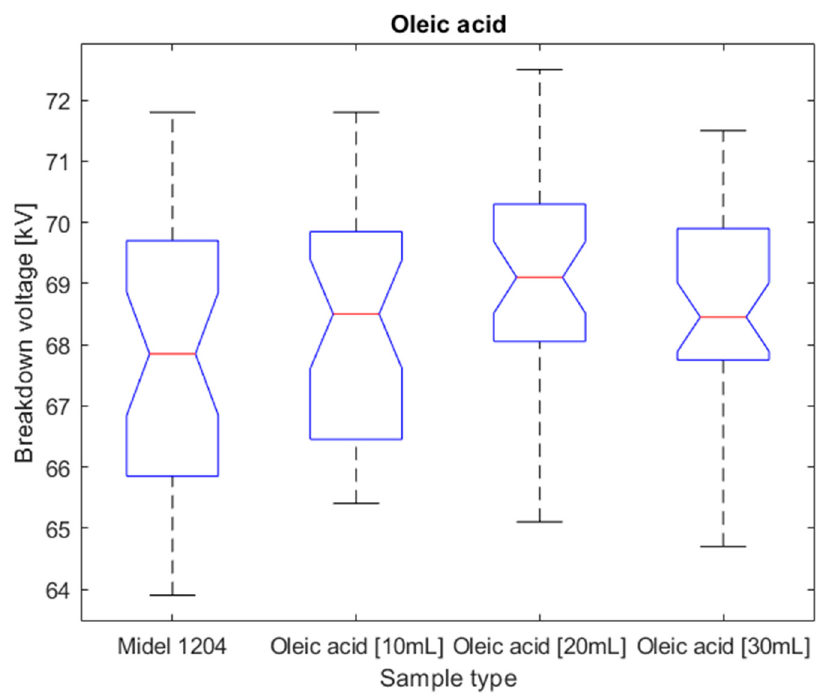
Figure 14. Box plot for surfactant population of oleic acid.